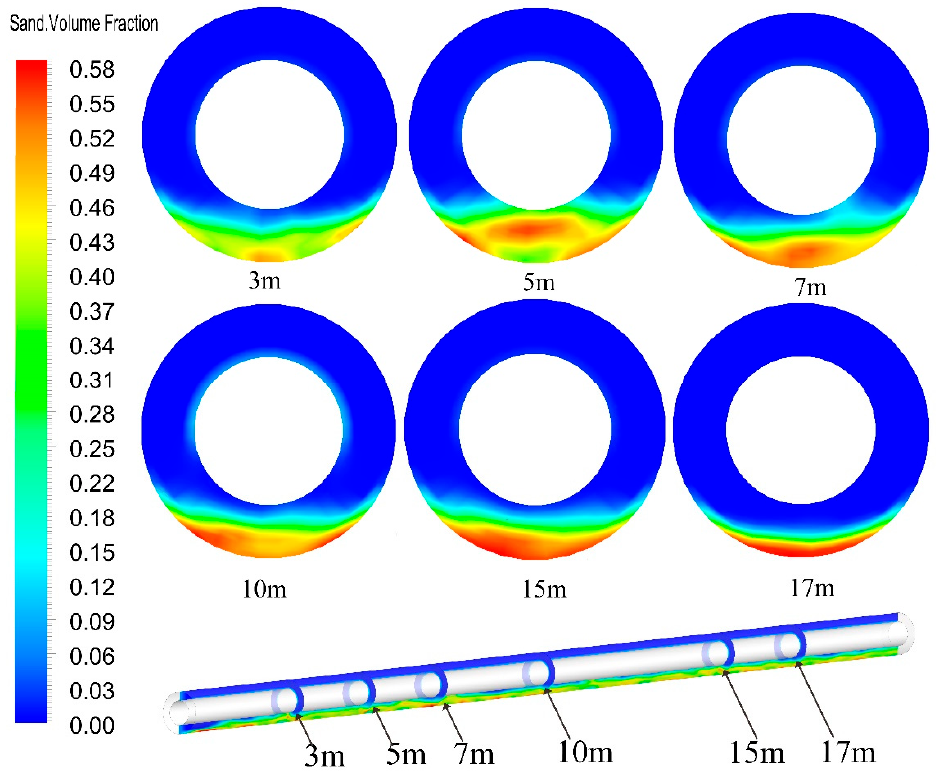
Figure 9. The contour of volume fraction for conventional gravel packing in horizontal wells .